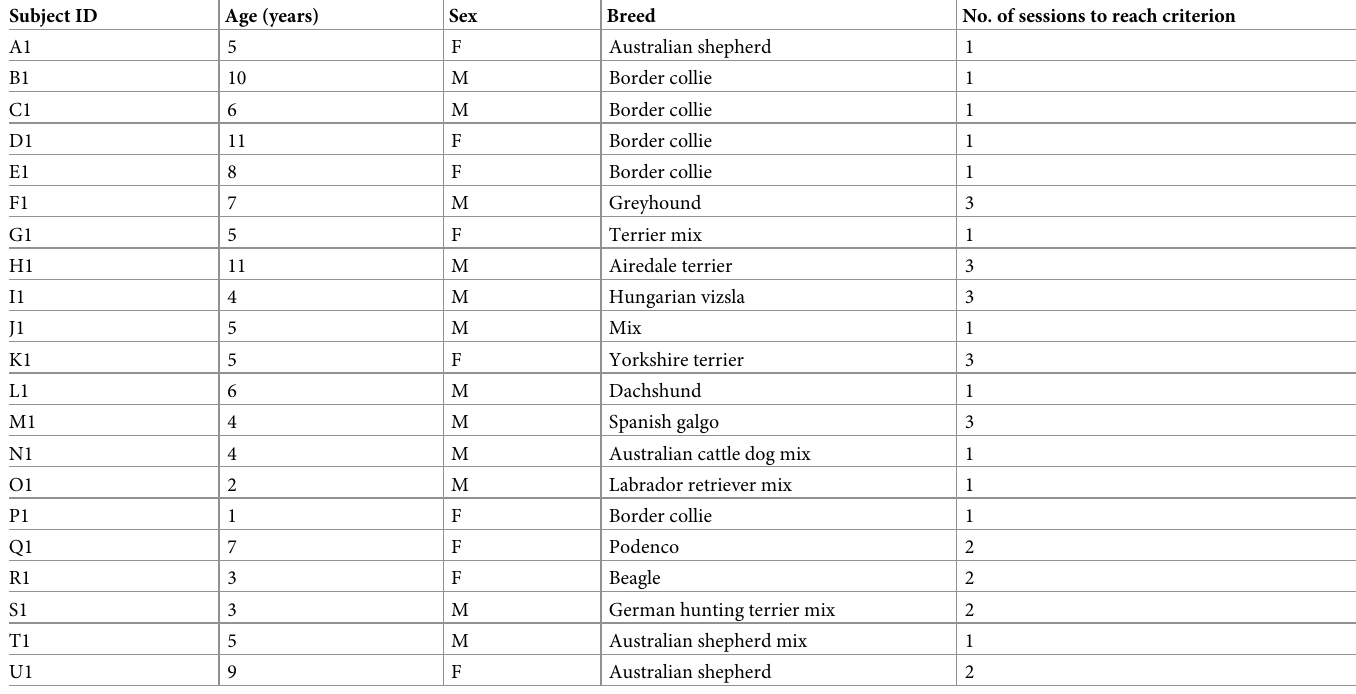
Table 1. Subject information including age, sex, breed, and the number of training sessions required to reach the